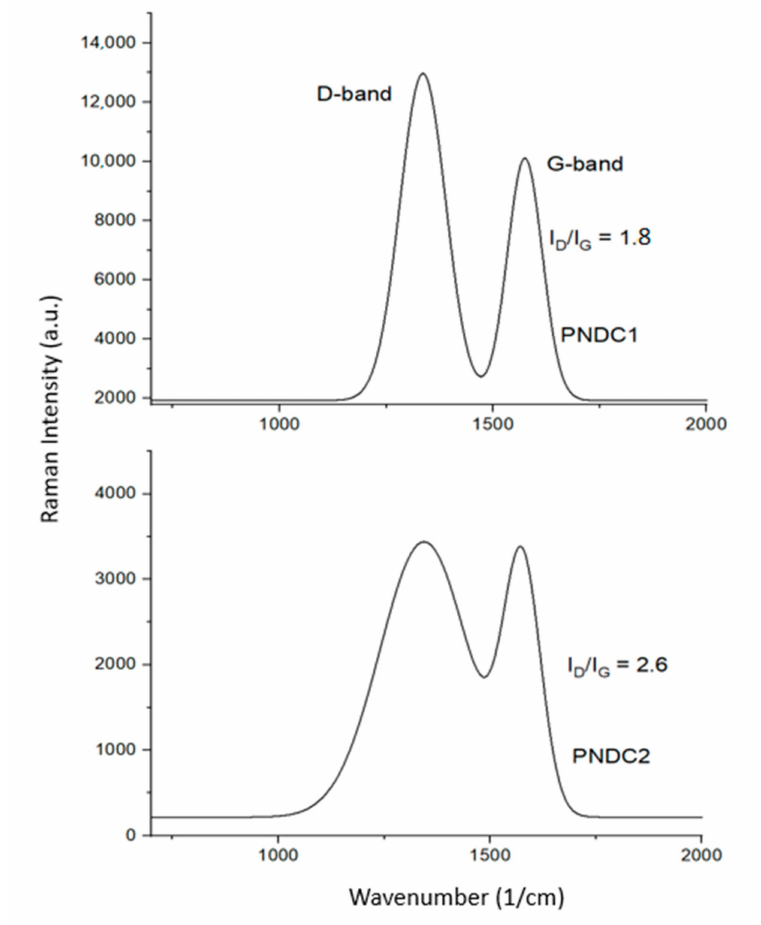
Figure 3. Raman spectra for PNDC